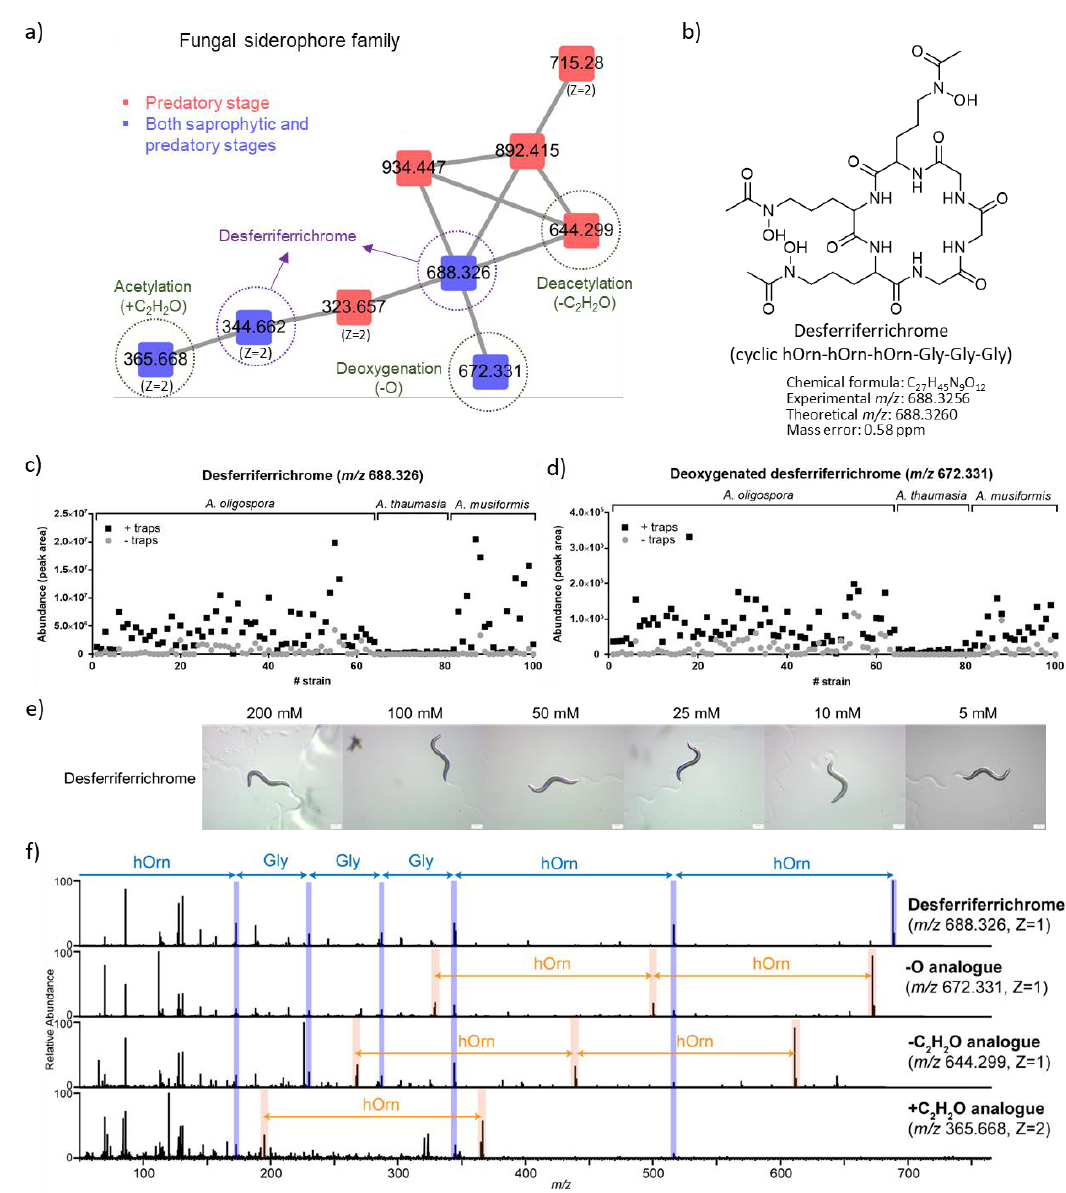
Figure 4. The fungal siderophore (desferriferrichrome) and its structural analogues. ( a ) The molecular family of desferriferrichrome. The nodes representing desferriferrichrome and three structural analogues were highlighted. The m / z values of the nodes are shown, and the doubly-charged nodes are particularly denoted as Z = 2. ( b ) The chemical structure of desferriferrichrome: a cyclic peptide composed of three glycine (Gly) monomers and three modified ornithine residues with hydroxamate groups (hOrn). ( c , d ) The abundance of the siderophores (exemplified by desferriferrichrome in ( c ); deoxygenated analogue in ( d )) in each Arthrobotrys strain before and after forming the traps was shown. The level of the siderophores was decreased in the A. thaumasia strains. Abundance was estimated by the LC–MS peak area. ( e ) The nematicidal activity test of desferriferrichrome. ( f ) Tandem mass spectrometric interrogation of desferriferrichrome and its structural analogues. The fragments indicating hydroxamating ornithine or glycine monomer are highlighted.